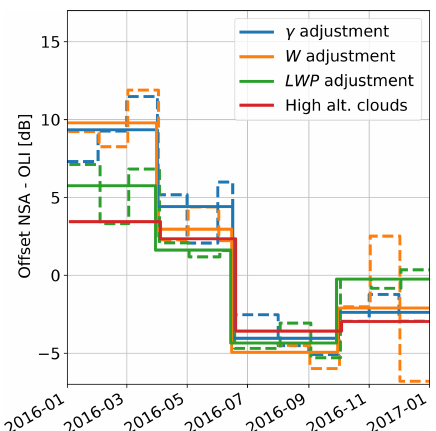
Figure 9. Comparison relative calibration offsets NSA–OLI for dif- ferent cutoff heights (colored lines). The best estimate (see text) is highlighted in black.